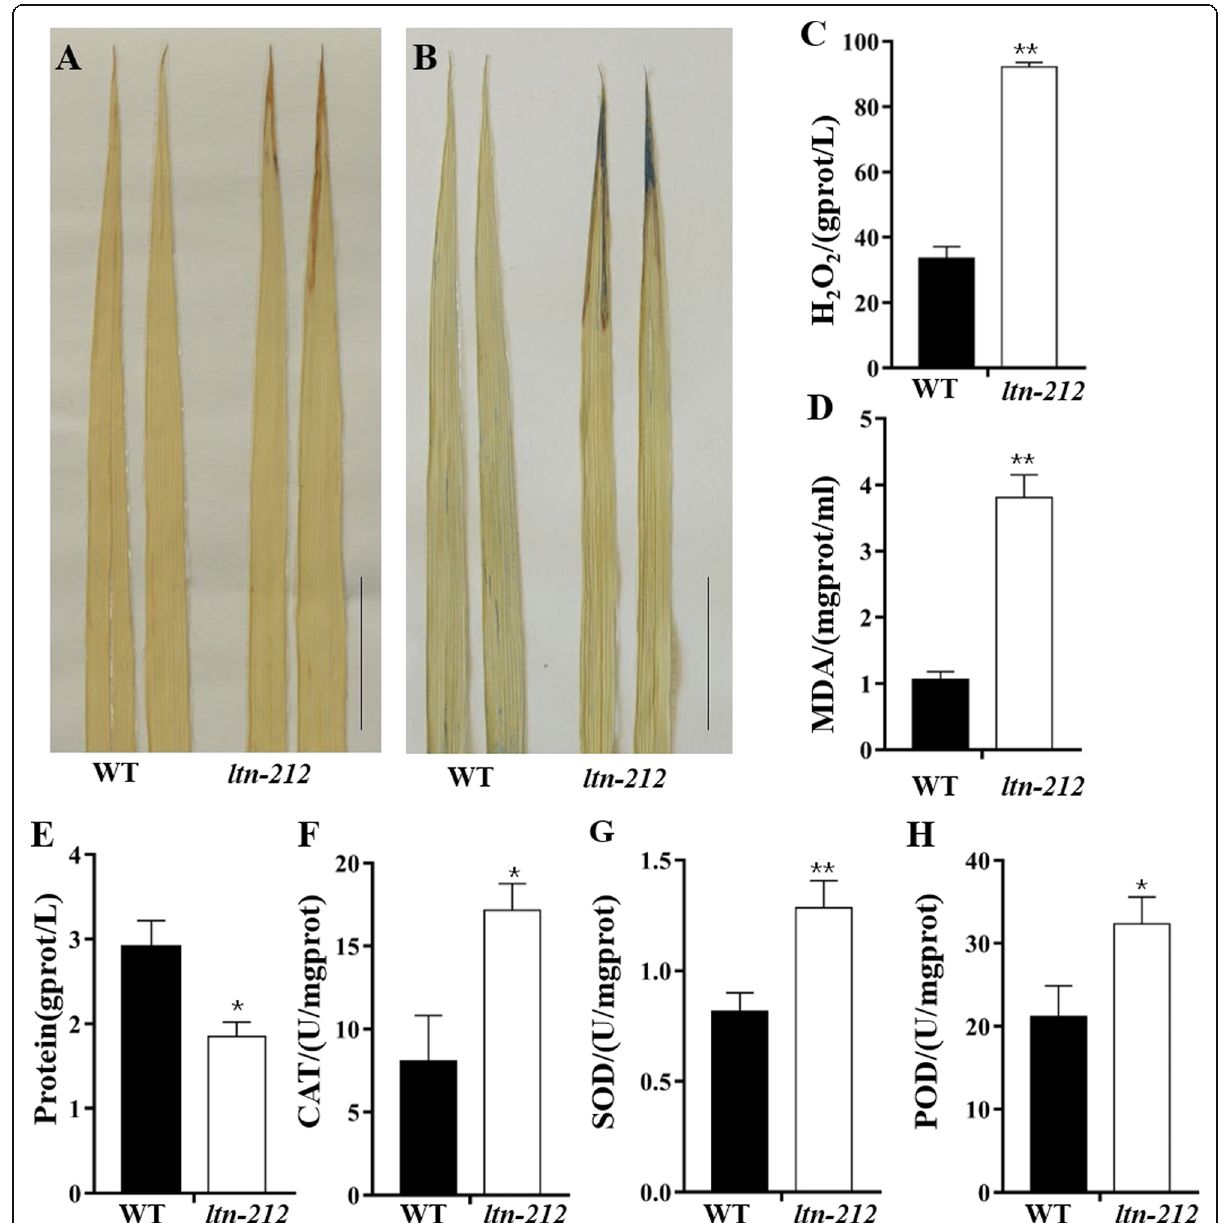
Fig. 2 Histochemical staining of WT and ltn-212 . a-b DAB staining and Evans blue staining at heading stage (scale bar = 5 cm). c-d H 2 O 2 content and MDA content at heading stage ( n = 3). e-h Total protein content and the activity of reactive oxygen species scavenging enzymes (CAT, SOD, POD, n = 3). Data are means ± SD. ** indicates significance at P ≤ 0.01 and * indicates significance at P ≤ 0.05 (Student ’ s t